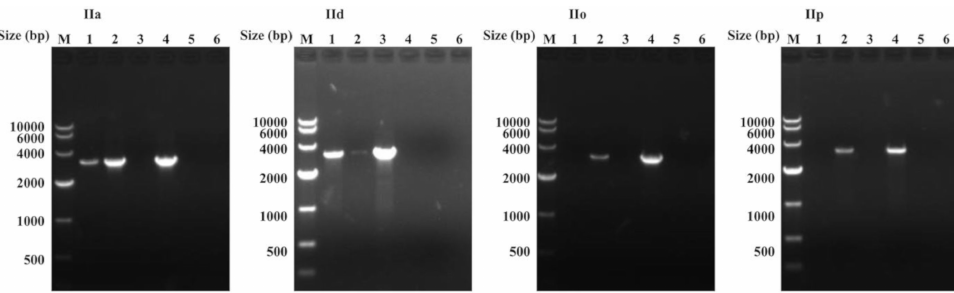
Figure 2. PCR amplification of the cgd6_5520-5510 gene in Cryptosporidium parvum IIa, IId, IIo,